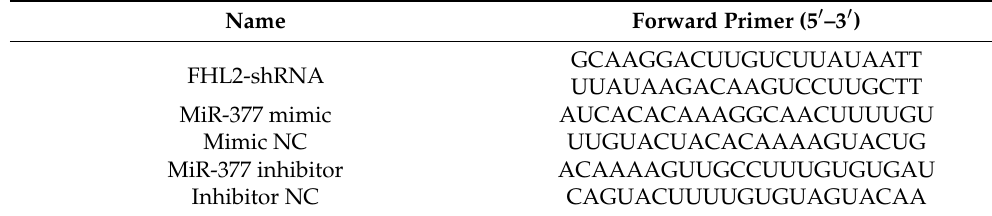
Table 1. RNA oligonucleotides in this